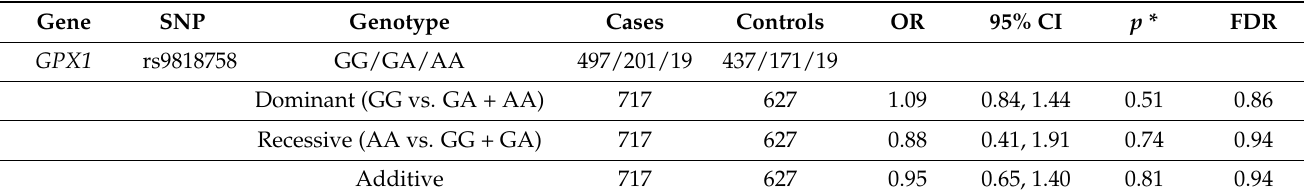
Associations of the selenoprotein gene variants with colorectal cancer risk in the Czech